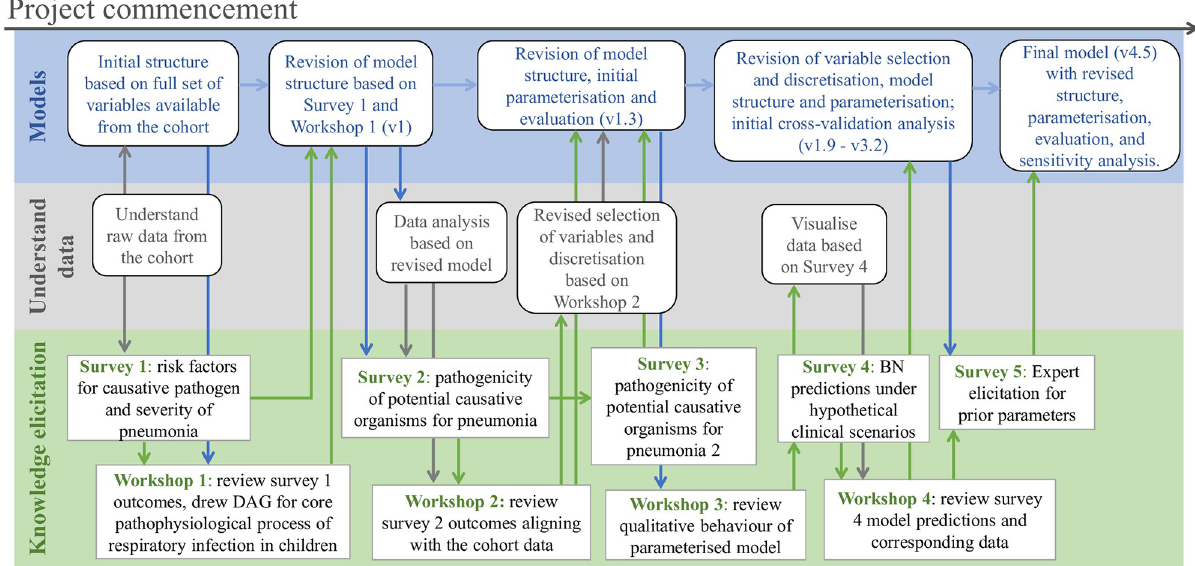
Fig 1. The schematic of BN development. The top blue row presents the development of the BN from its initial form (left) to the fourth iteration (right), and how this iteratively interacts with the data analysis (middle grey row) and the knowledge elicitation (KE, bottom green row). Everything is primarily designed to support model development; however the models themselves also support and drive data analysis and KE. In some cases, there are also direct interactions between data analysis and KE. During the KE process, survey outcomes often directly guide the design and focus of the following workshop. As the BN is developed and revised over several iterations, any data analysis, KE or modelling outcomes from an earlier iteration may inform any of these activities in the next iteration.